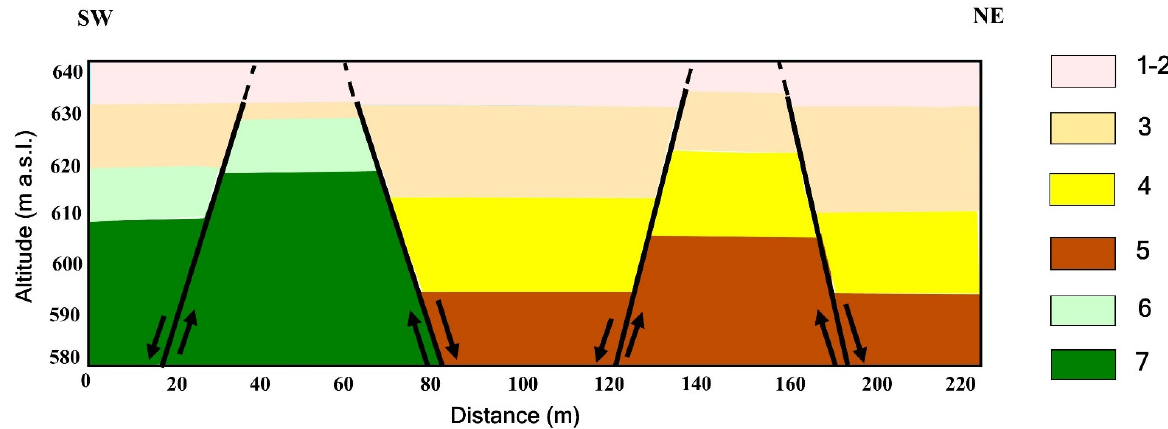
Figure 13. Geological interpretation along the Seis_1 profile (see location in Figure 3a): black dashed lines show the identified synthetic and antithetic normal faults and black arrows indicate the direction of displacement. Legend: (1–2) Slope and lacustrine deposits (Late Pleistocene-Holocene); (3) cemented limestone breccias (Middle–Late Pleistocene); (4) calcarenites, calcilutites, and marly limestone (Serravallian–Tortonian); (5) marly limestone and marl (Oligocene–Burdigalian); (6) calcarenites and cherty limestones (Senonian–Turonian); and (7) mesozoic limestone succession (Cenomanian– Early Turonian). Wehere merged geological units 1 and 2 of Figure 1 in one geological unit.